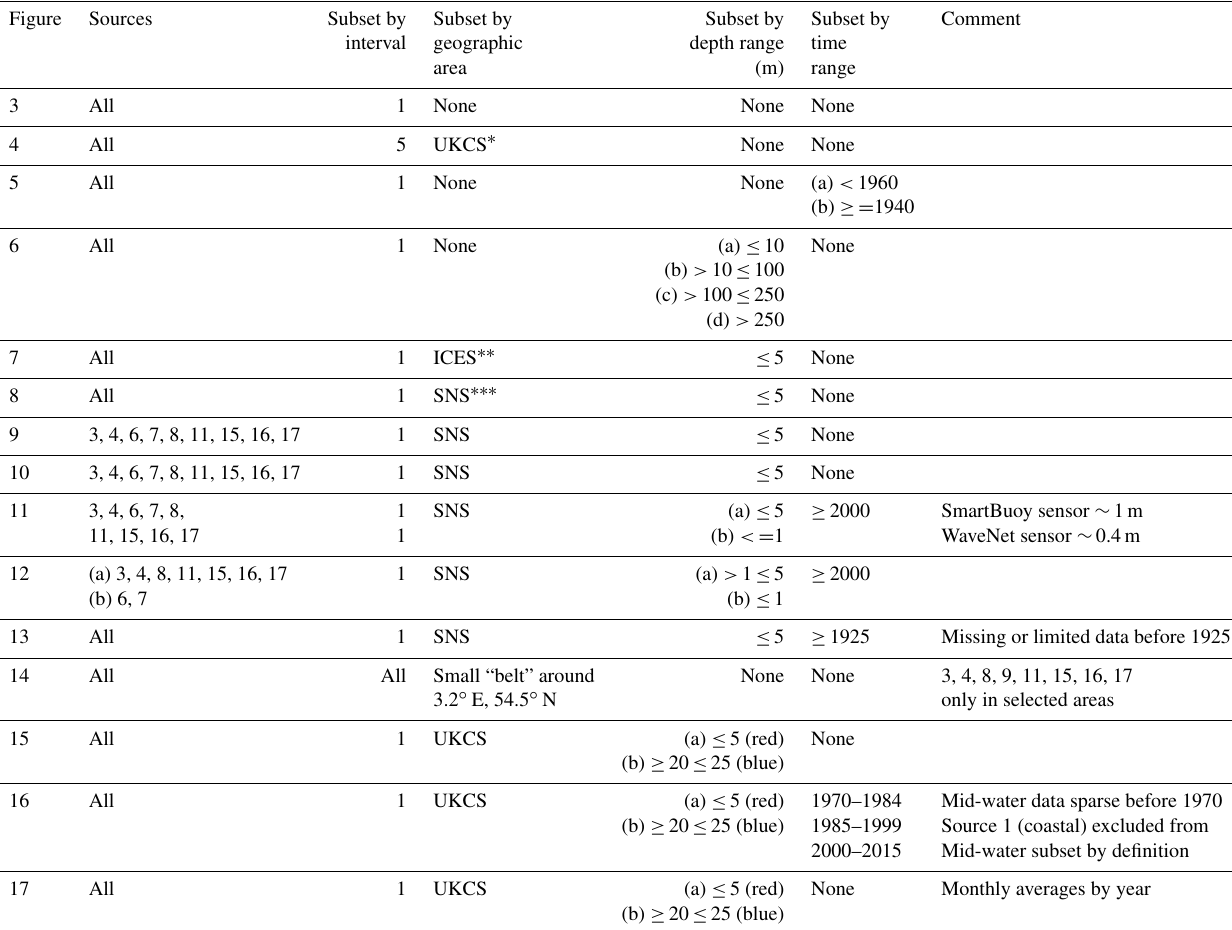
Table 3. Summary of data sources: geographic, depth, and temporal ranges for the subsetted data used in the figures. Figure Sources Subset by Subset by Subset by Subset by Comment interval geographic depth range time area (m) range 1 None